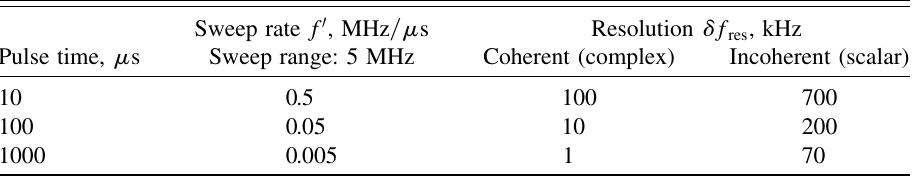
TABLE I. Resolution limits for sweep range 5 MHz and several pulse times. For coherent measurements, the resolution is limited by the inherent linewidth. For incoherent, it is consid- erably worse and scales as inverse square root of the pulse duration.